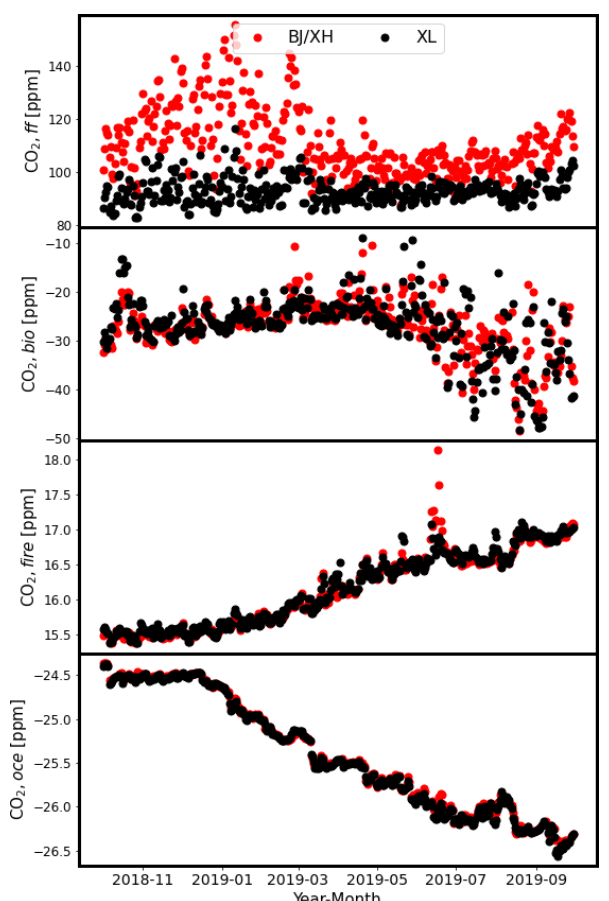
Figure 6. The time series of CO 2 simulations from fossil fuel (CO 2 , ff ), biosphere (CO 2 , bio ), fire (CO 2 , fire ), and ocean (CO 2 , oce ) modules at BJ/XH and